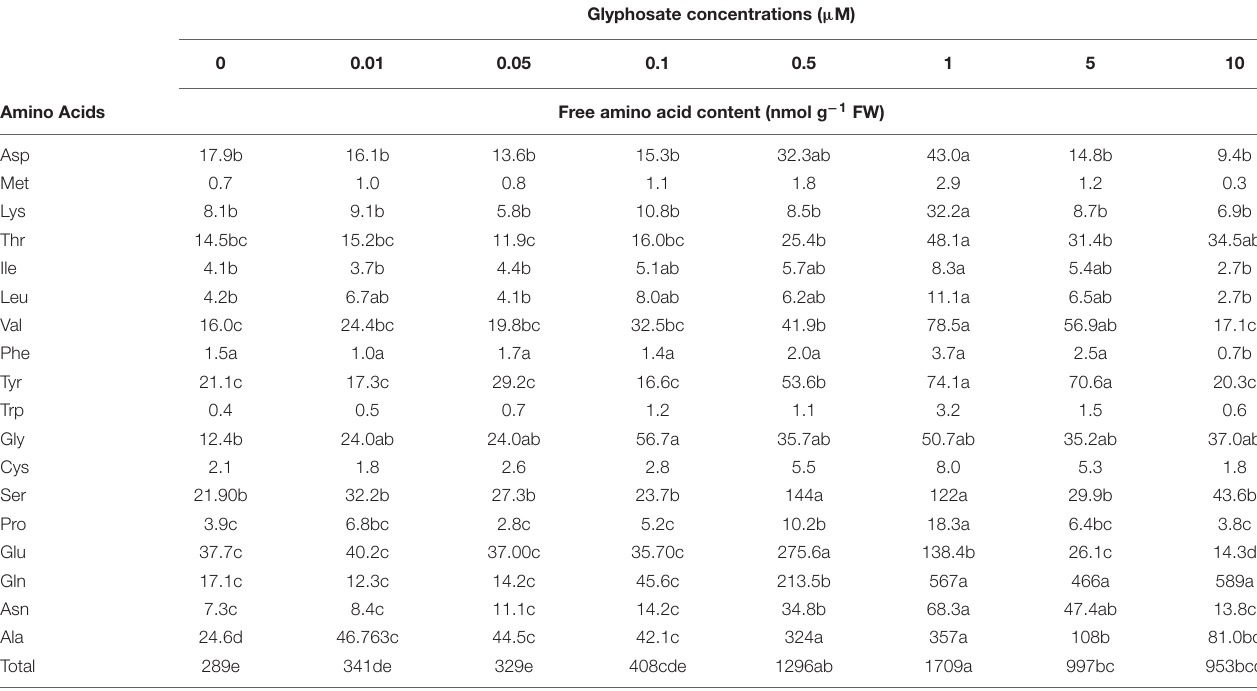
TABLE 4 | Free amino acid content in P. aegyptiaca callus grown in BCGM with embedded